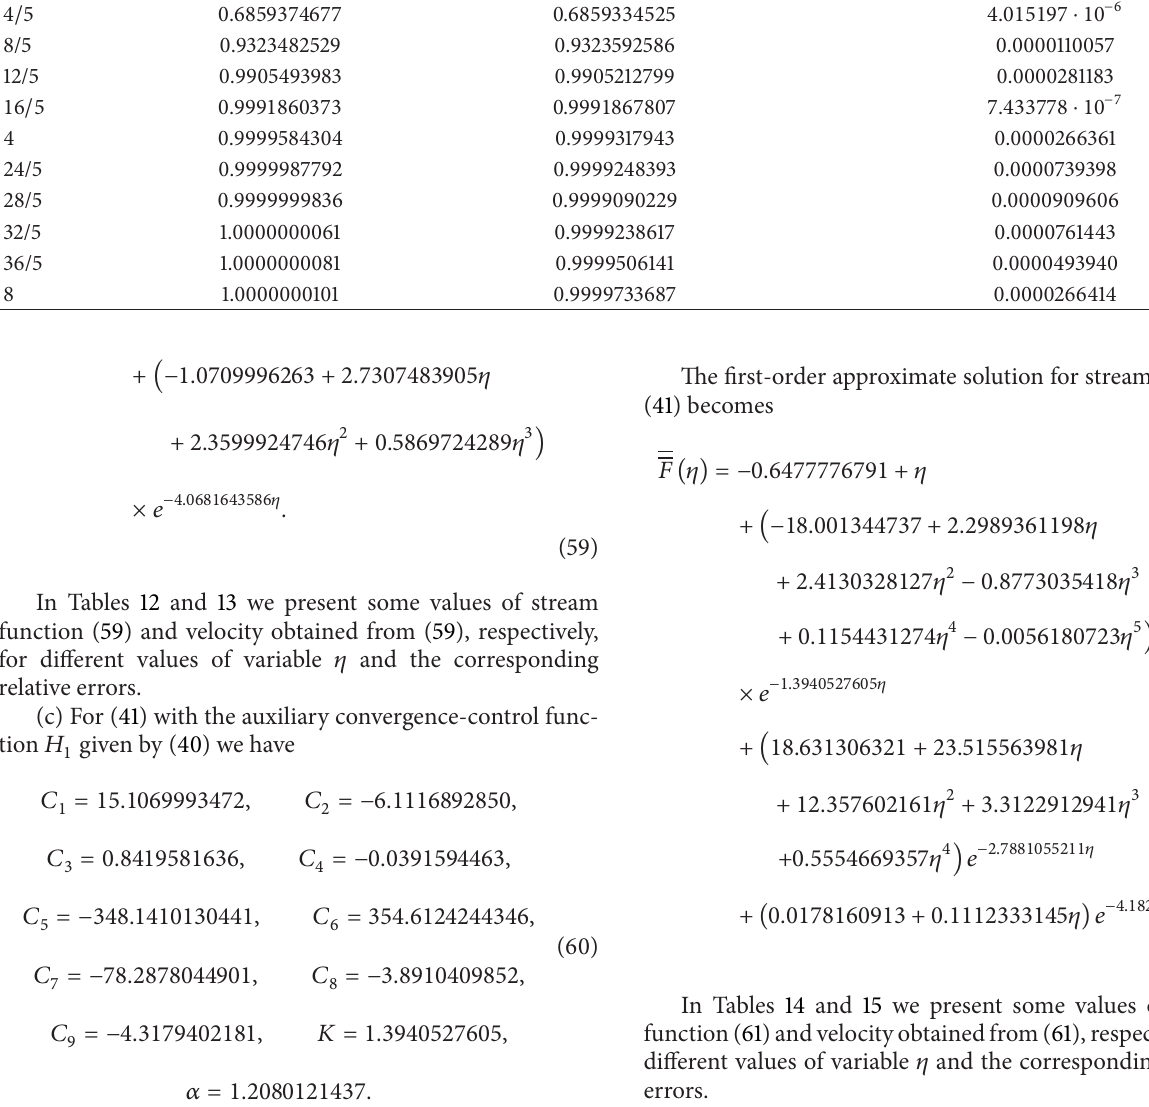
Table 13: Comparison between OHAM results for velocity 𝐹 𝜂 𝐹 󸀠 numerical